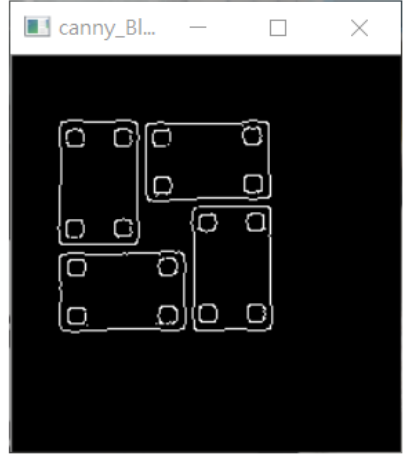
Figure 26. Canny edge detector.